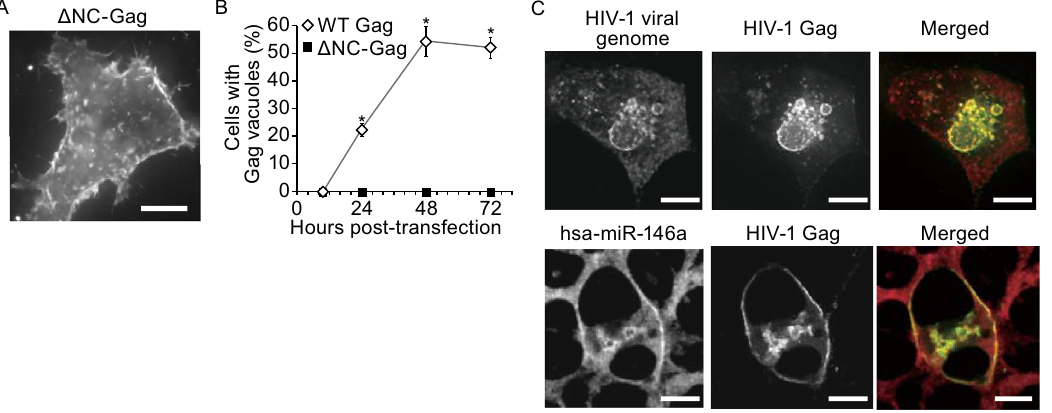
Figure 2. Interaction of miRNAs with HIV-1 Gag proteins drives intracellular Gag redistribution. (A) Representative fl uorescence micrograph of Δ NC-Gag in MiR + cells. MiR + cells were transfected with pNL43 Δ P Δ E Δ NC-Gag-EGFP and imaged at 48 h post-transfection. Note that Δ NC-Gag does not form intracellular vacuoles. (B) Time-course quanti fi cation of Gag vacuole formation by Δ NC-Gag as compared with wildtype Gag in MiR + cells. Data represent mean ± SD of at least three replicates. Each replicate experiment was performed by examining at least 200 transfected cells. (C) Representative images of hsa-miR-146a or HIV-1 viral genome (detected by FISH) and Gag (detected by Gag-EGFP) in MiR + cells transfected with pNL43 Δ P Δ